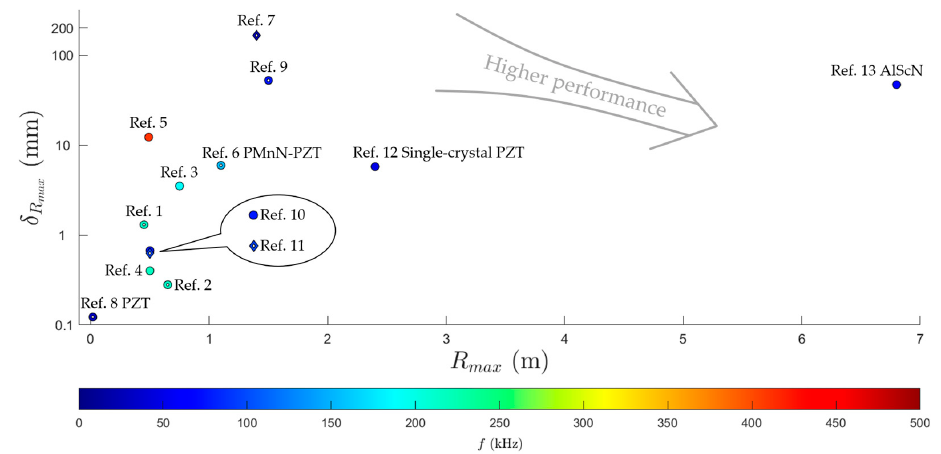
Figure 12. Performance comparison illustration of different TOF pMUT rangefinders. All the ranges and the corresponding range errors that are measured by the distance between the transmitter and the receiver are divided by two to be converted to the reflection mode results for performance com- parison. 3 𝜎 errors are divided by three to be converted to the RMS errors. For those pMUT range- finders that did not report their maximum range errors, 𝛿 (cid:3019)(cid:3040)(cid:3028)(cid:3051) is estimated by Equation (8), where the sound speed is set to be 𝑐 = 343 m/s according to [103] . Data are from Ref. 1 ( [33] ), Ref. 2 ( [11] ),